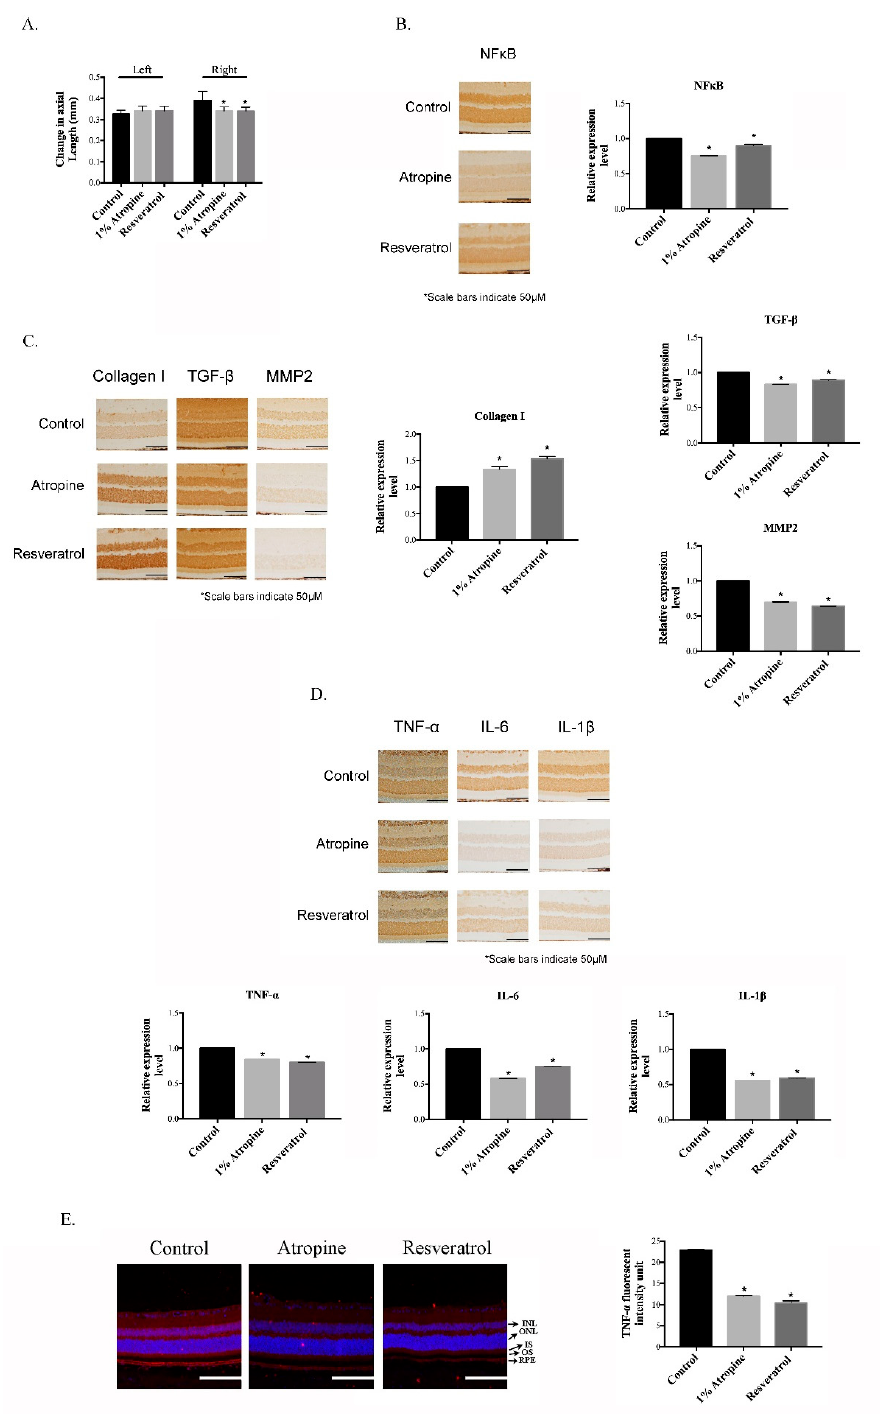
Figure 1. Effect of resveratrol on myopia progression. ( A ) The axial length was determined as the difference in diopter measurements taken after and before MFD. * p < 0.05 indicates significant differences from the control. Quantification of immunohistochemical staining for NF κ B ( B ), collagen I, TGF- β , and MMP2 ( C ), and TNF- α , IL-6, and IL-1 β ( D ). ( E ) Immunofluorescence staining with TNF- α and quantification analysis of the RPE layer by Image J software. Results are shown as mean ± SD; The scale bar indicates 50 µ m, 20 × magnification for IHC stain images, 100 µ m, 20 × magnification for IF stain images * p < 0.05, n = 3 for